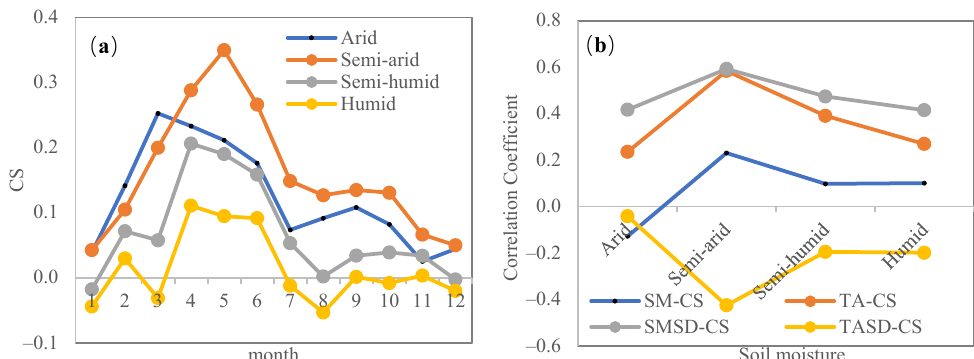
Figure 12. ( a ) Intra-annual variation in ET-P CS and ( b ) its correlation coefficients with soil moisture (SM), standard deviation of soil moisture (SMCD), air temperature (TA) and standard deviation of temperature (TASD) under different dry-wet climatic backgrounds.